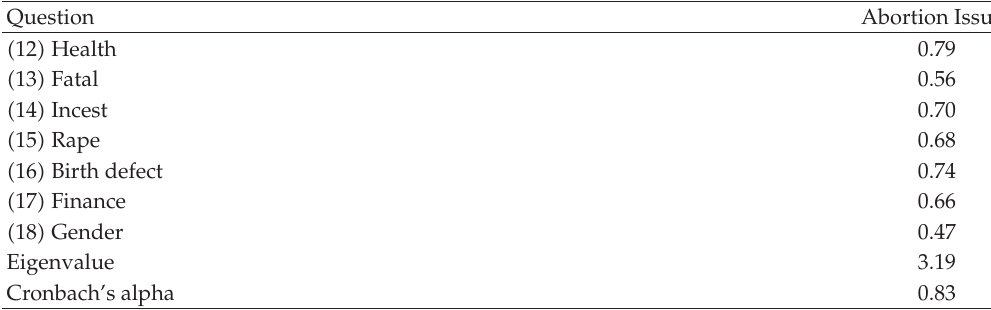
Table 1: Factor loadings for abortion.